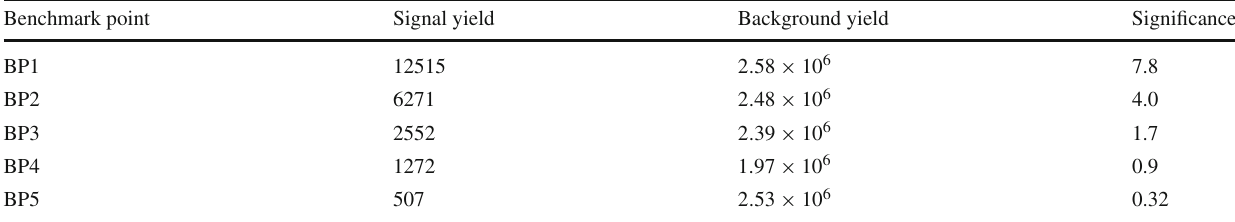
Table 12 The signal and background yields at 14 TeV-LHC and 3 ab − 1 integrated luminosity for BP1, BP2, BP3, BP4 and BP5 along with signal significances for the pp → 2 (cid:3) + E T / channel after the BDTD analysis